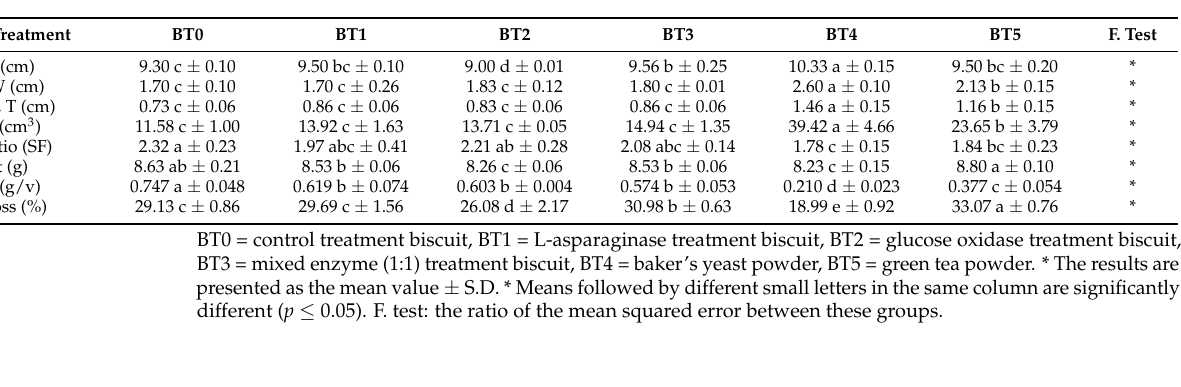
Table 5. Physical characteristics of processed